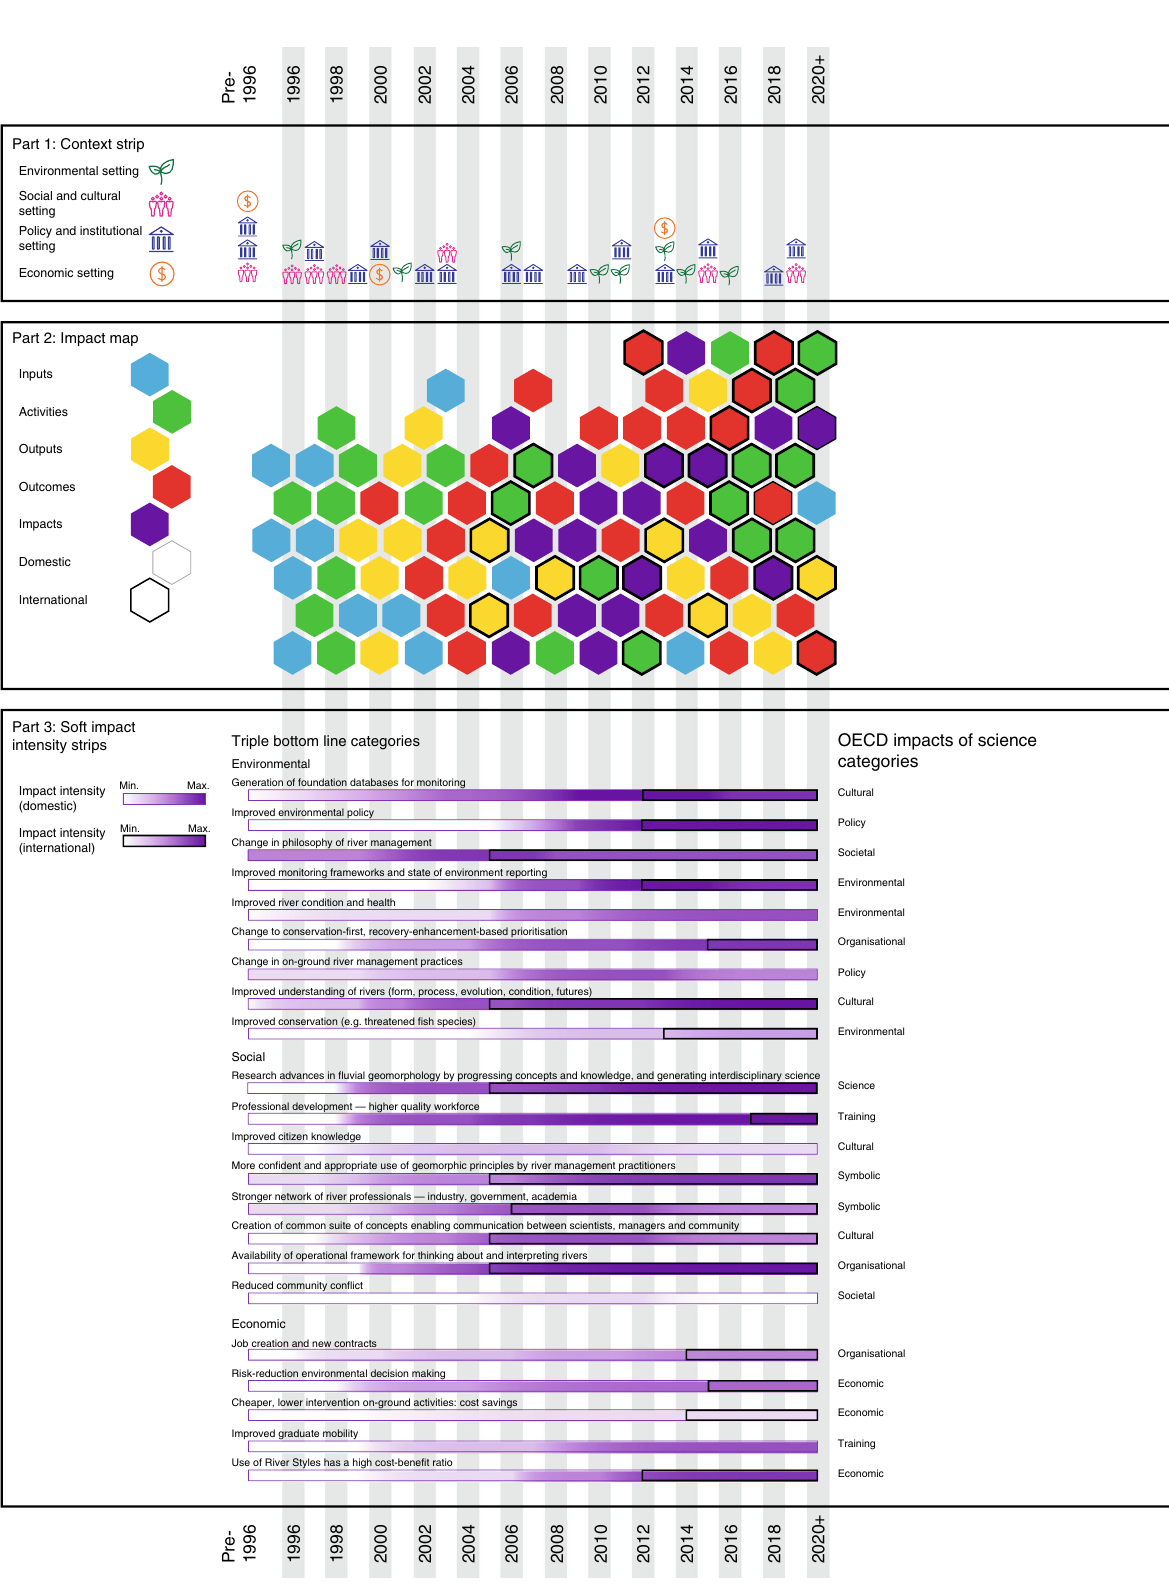
Fig. 2 The research impact map for the River Styles Framework case study. This map contains 3 parts, a context strip, impact map and soft impact intensity